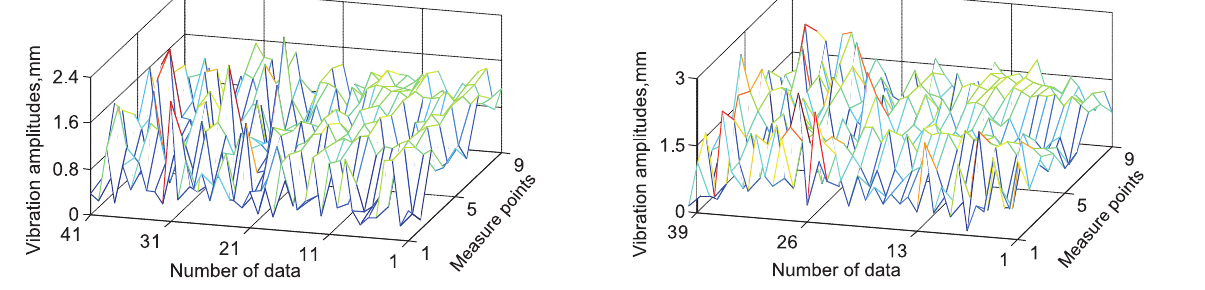
Fig. 5. 3-D graphics of the vibration signals for rotor-to-stator rub. Fig. 6. 3-D graphics of the vibration signals for